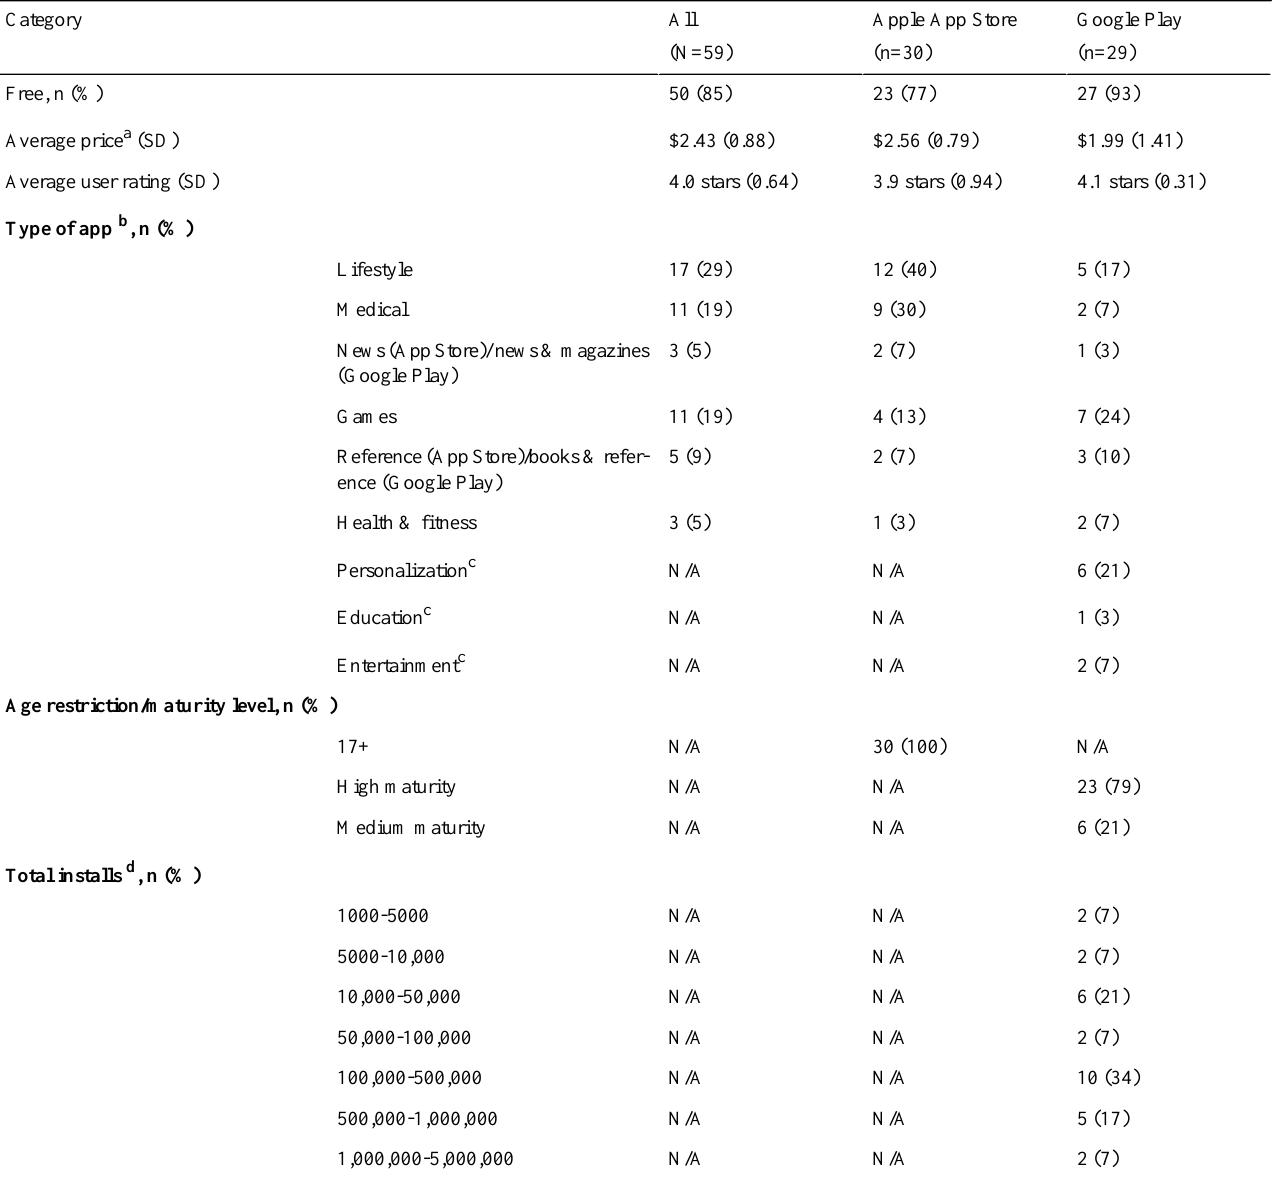
Table 1. Overview of mobile cannabis/marijuana apps